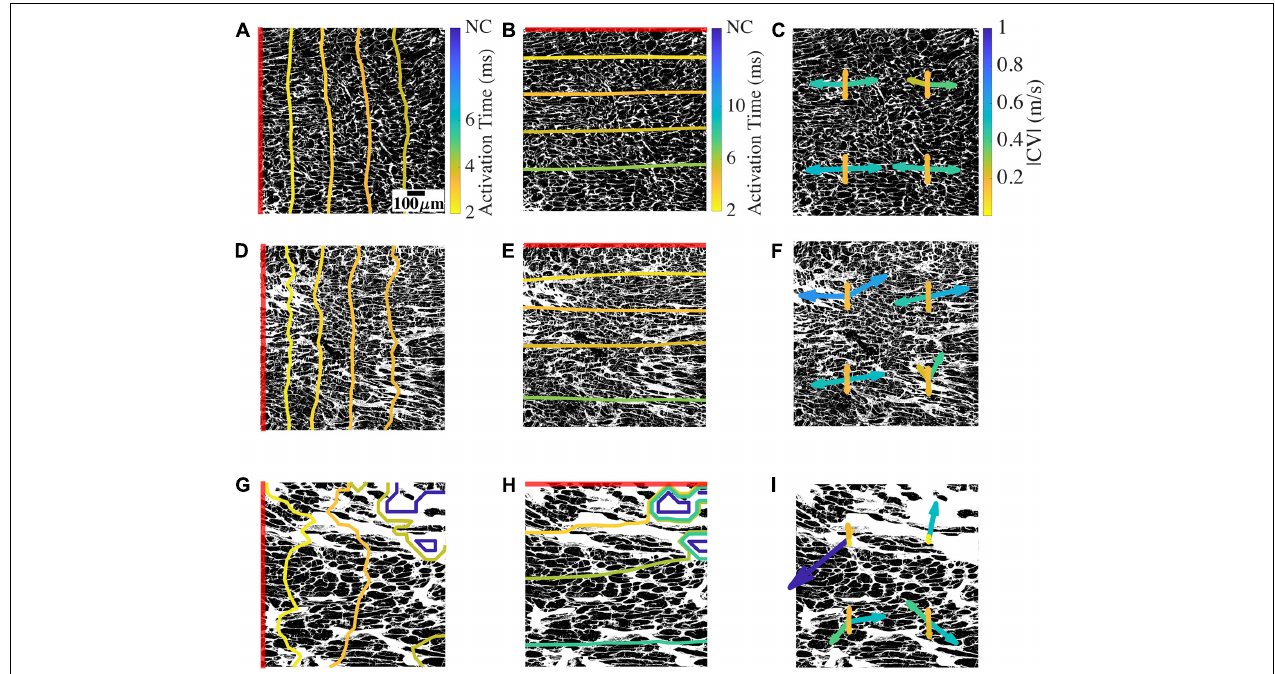
FIGURE 4 | Conduction and CV in bidomain model based on a representative donor, low fibrosis HF, and high fibrosis HF tissue. (A) Longitudinal conduction in an example donor tissue shown by activation times as contour plot overlayed on the non-myocyte fraction from which the mesh was generated. (B) Transverse conduction in the donor. (C) CV vectors at four positions in the mesh. At each position, two CV vectors correspond to longitudinal conduction from left to right and right to left, and two CV vectors correspond to transverse conduction from top to bottom and bottom to top. (D–F) Conduction and CV vectors for low fibrosis HF. (G–I) Longitudinal and transverse conduction and CV vectors for high fibrosis HF. The red line segment in each image shows the location of the applied stimulus. NC indicates no conduction. Scale bar in panel (A) applies to all figures. Color bar in panel (A) applies to panels (D,G), (B) applies to panels (E,H) , and (C) applies to panels (F,I)